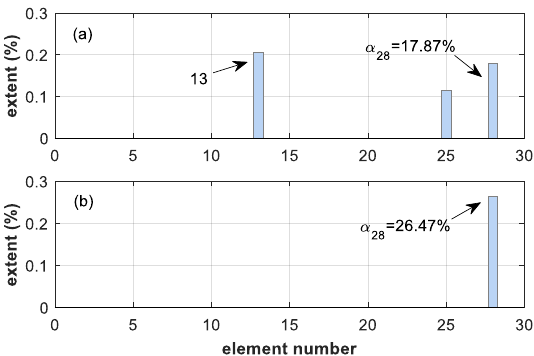
Figure 16. Damage identification results of damage case E at a 3% level of noise, with an iterative Tikhonov solution: ( a ) CMSE method; ( b ) RCMSE method.